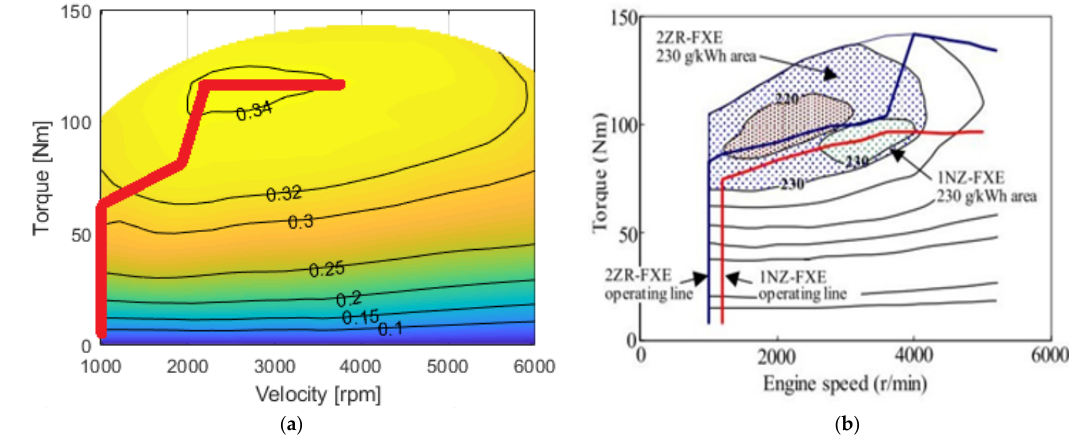
Figure 8. ( a ) ICE optimal work points; and ( b ) Toyota ICE work points (Reprint with permission [16]; Copyright 2012, VDI-Verlag).